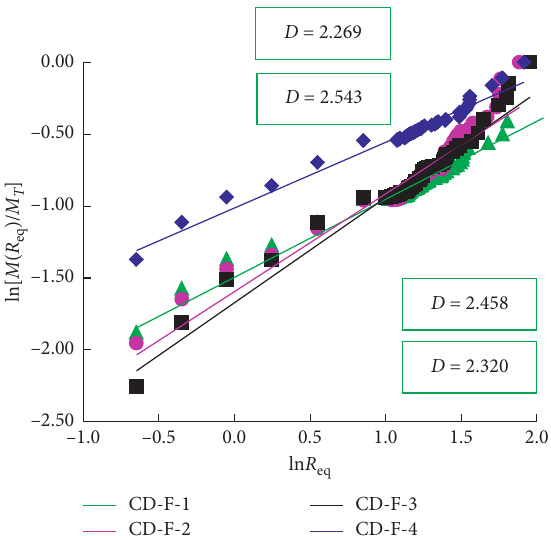
Figure 8: Calculation of fractal dimensions under different dis- turbance frequency